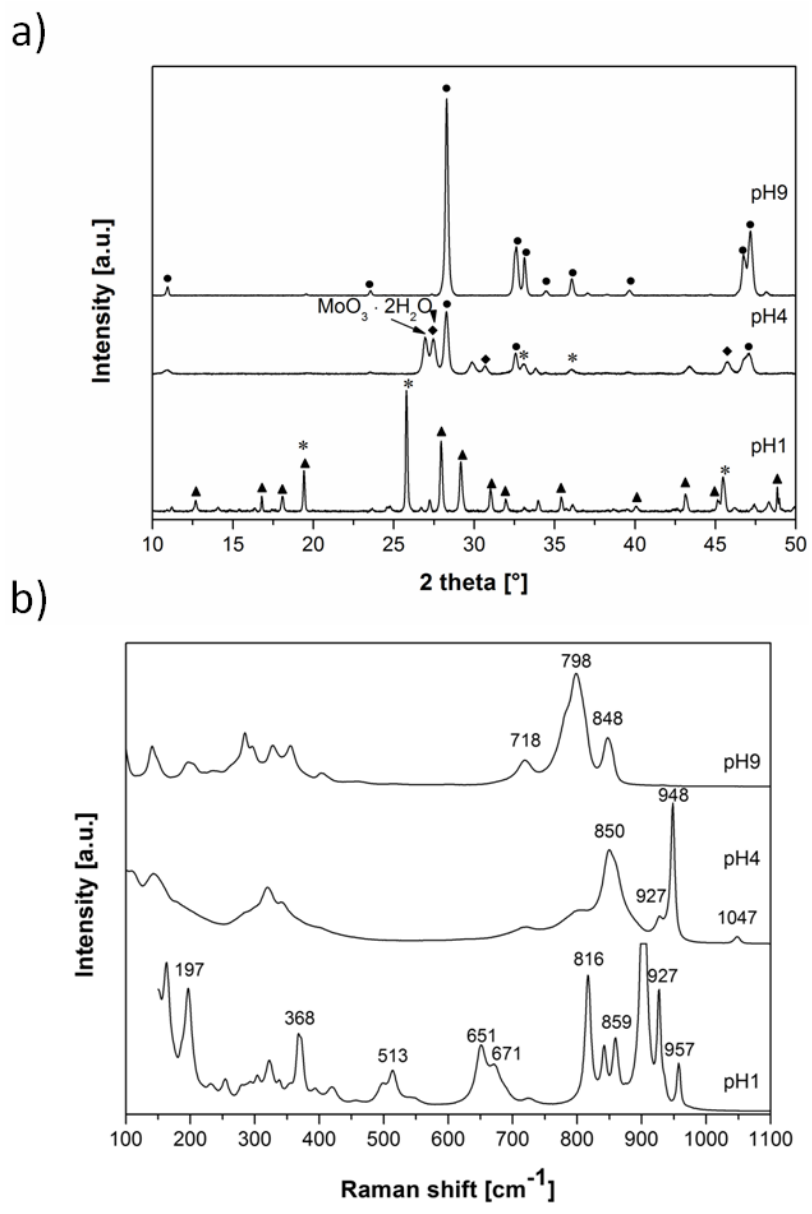
Figure 2. XRD patterns ( a ) and Raman spectra ( b ) of the samples with Bi/Mo = 2/3 at different pH values. The following symbols are used for the different phases: α-Bi 2 Mo 3 O 12 (▲), γ-Bi 2 MoO 6 (●), H 0.68 (NH 4 ) 2 Mo 14.16 O 4.34 ∙6.92H 2 O (*) and Bi 5 O 7 NO 3